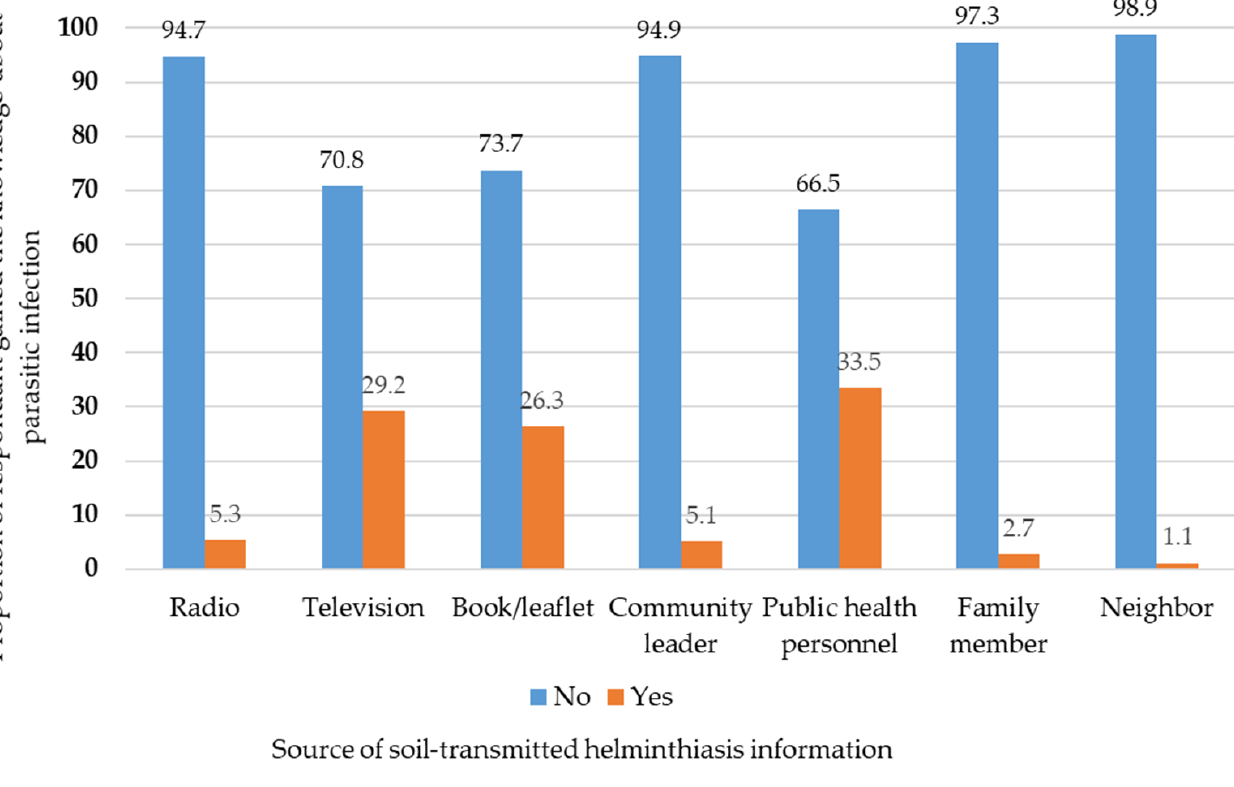
Figure 3. Proportion of respondents advised to check for parasitic diseases by source of advice.